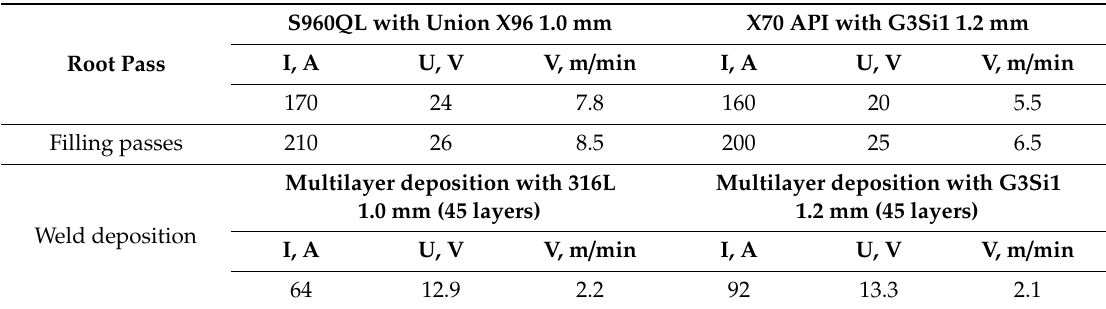
Table 1. Welding parameters for S960QL, X70 API welding and the multilayer weld deposition.